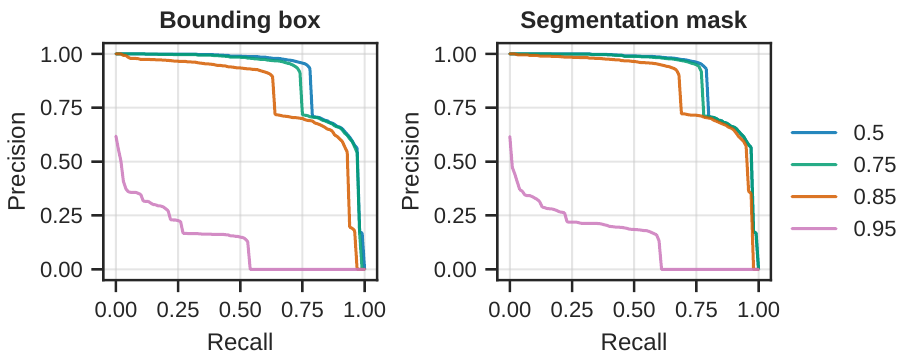
Figure 9. Precision-recall curves at different IoU thresholds, where each curve is based on the average for all four object classes. ( Left ): PR curves for the detection (bounding box) task. There is a sharp drop in precision at the approximate recall thresholds { 0.65,0.74,0.8 } , which corresponds to the lower precision of the “sediment” class. ( Right ): The same drop in precision is observer for the predicted masks, which can again be explained by the performance on the “sediment” class.